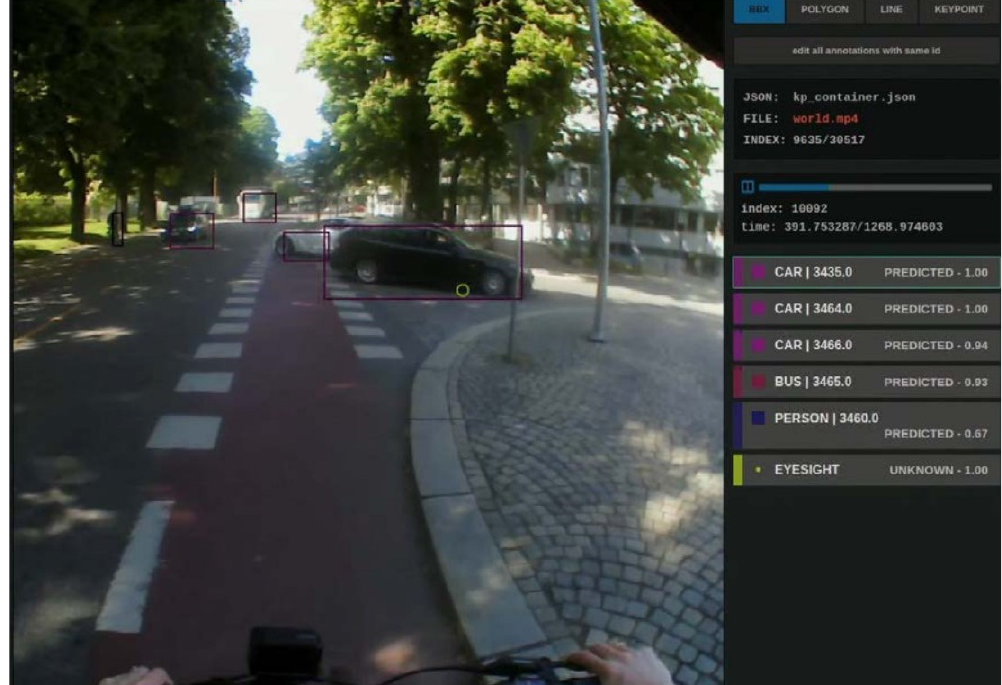
Figure 3 Example of analysis from eye-tracker video: eyesight, categorizations, and actual